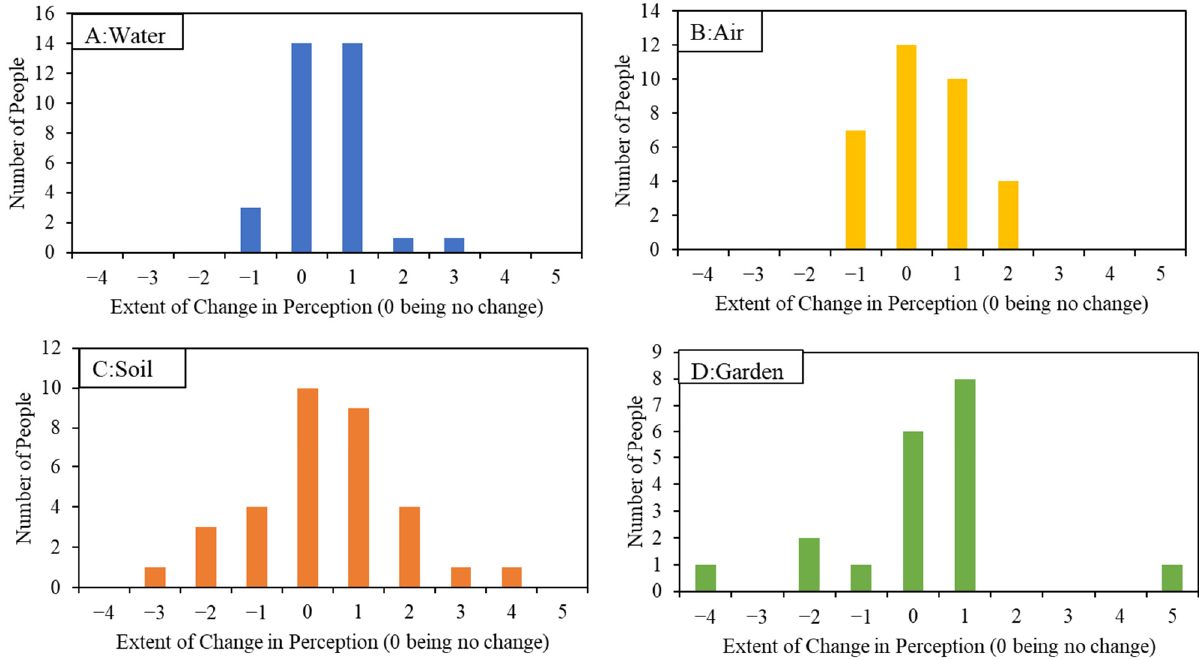
Figure 7. Aggregated change in perceptions before and after intervention. Change in perception is the perception difference between before and after intervention rating. Perceptions were reported on a 6-point Likert-type Scale: 1: Very Good; 2: Good; 3: Somewhat Good; 4: Somewhat Bad; 5: Bad; 6: Very Bad. So, Positive x-axis numbers (meaning perception changed from a higher number to a lower number) indicate perceptions have improved.